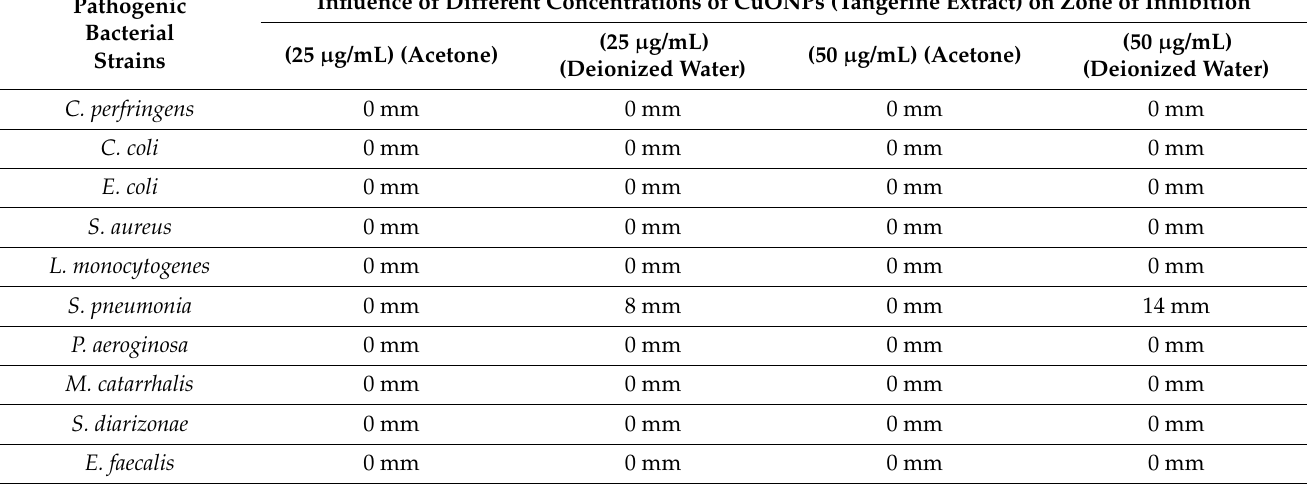
Table 3. Antibacterial activity of CuO-NPs-T on pathogenic bacterial strains.